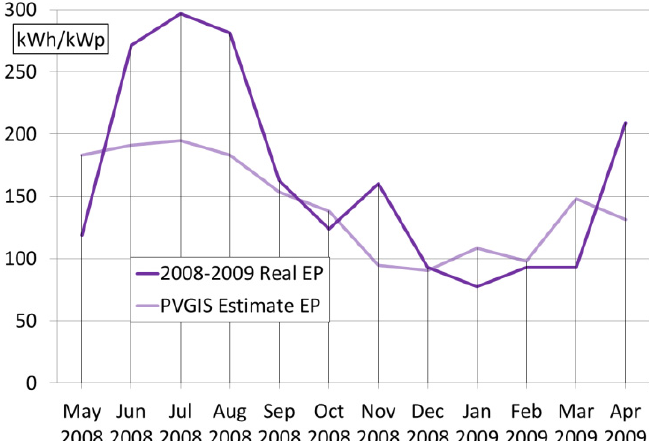
Figure 8. Real EP and the monthly PVGIS estimate of EP at the Sanlúcar la Mayor CPV installation for 2008–2009.